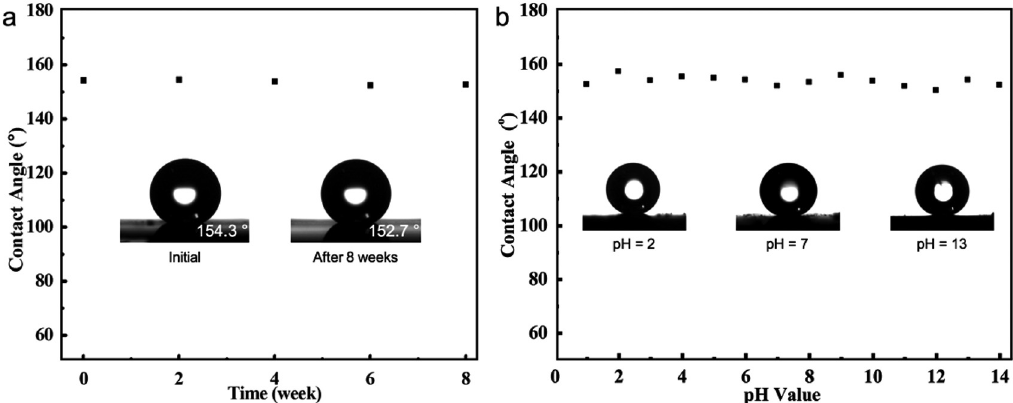
Figure 4: CAs of the SHPC CNT fi lm during ( a ) air ( ∼ 60% humidity ) and ( b ) corrosive liquid exposure [ 93 ] . Reproduced with permission from ref. [ 93 ] ; © 2017 American Chemical